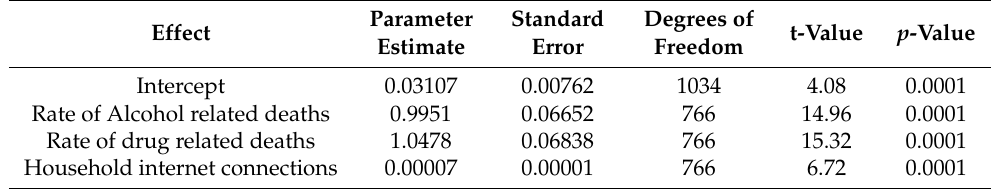
Table 2. Longitudinal Analysis Model